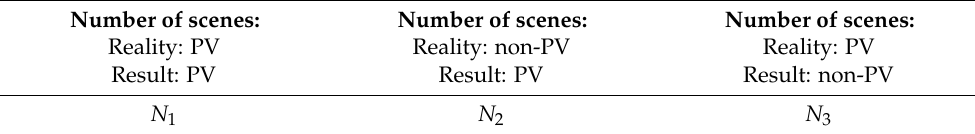
Table 3. Scene classification prediction result parameters.